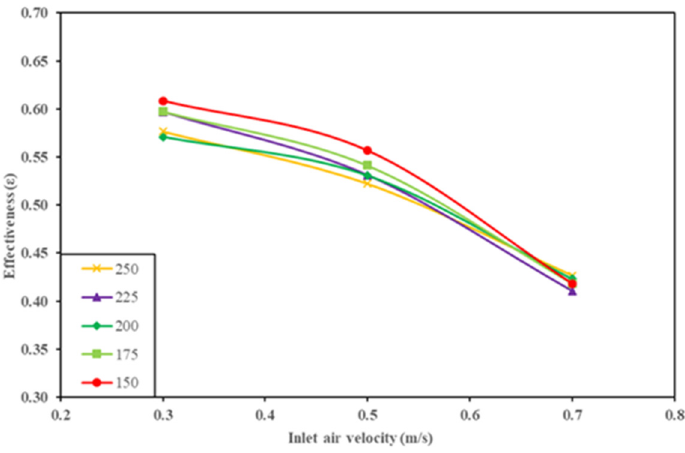
Figure 7. Effectiveness of the HPHE with respect to inlet air temperature for different inlet air ve- locities.